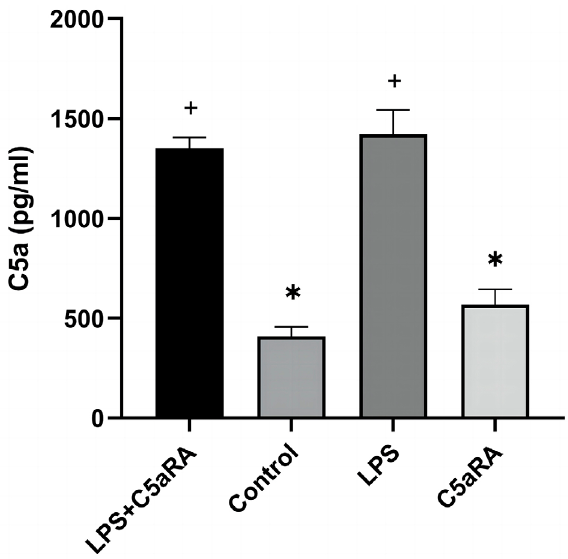
Figure 4- The content of C5a in the cell supernatant of the different group was measured by the ELISA assay. Data represent the mean ± SEM of three independent experiments. +P < 0.05 vs. the control group. *P < 0.05 vs. the LPS+C5aRA